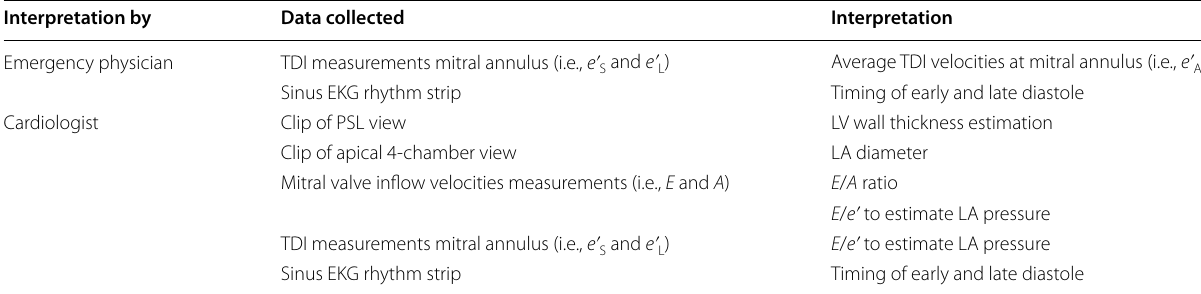
TDI, tissue Doppler imaging; PSL, parasternal long, e ʹ s , mitral annulus downward velocity at the septum; e ʹ L, mitral annulus downward velocity at the lateral wall; e ʹ A, average mitral annulus downward velocity measured ([ e ʹ S e ʹ L ]/2); E , peak mitral valve inflow velocity in early diastole; A , peak mitral valve inflow velocity in late + diastole; LA, left atrium; LV, left